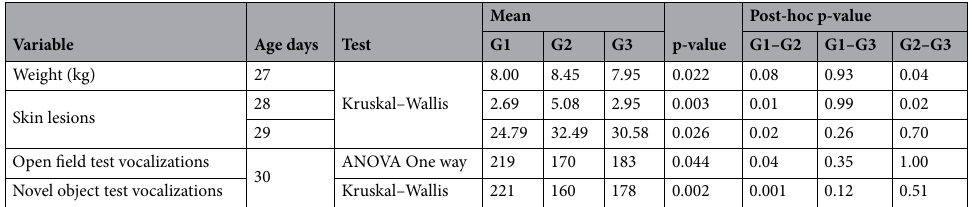
Table 5. Significant results of weight, number of skin lesions and number of vocalizations during open field and novel object test. The post-hoc test used to ANOVA One way was a Tukey and for Kruskal–Wallis was a Nemenyi test. Degrees of freedom always were 2.